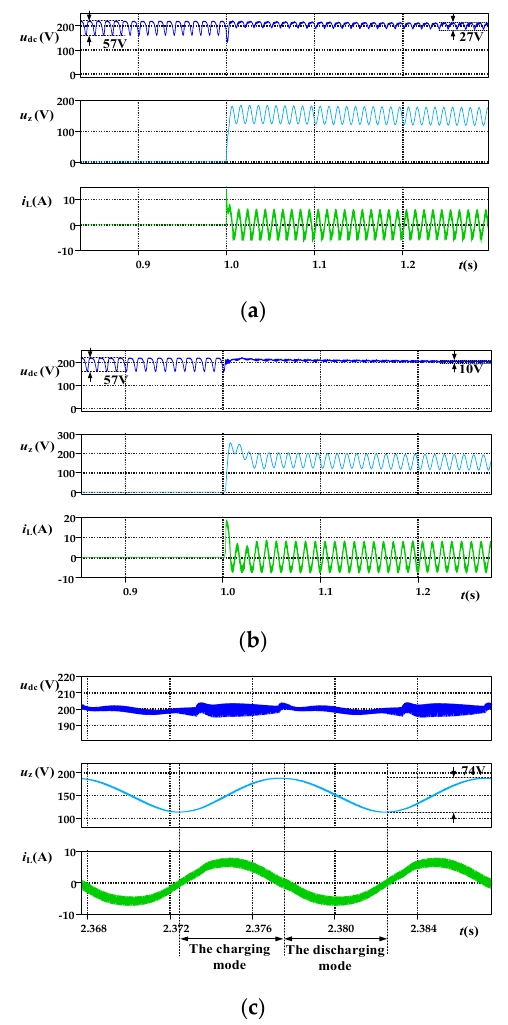
Figure 7. Comparison of steady-state simulation waveforms of the estimation method and the proposed method: ( a ) the estimation method; ( b ) the proposed method; and ( c ) the proposed method in two ripple periods.